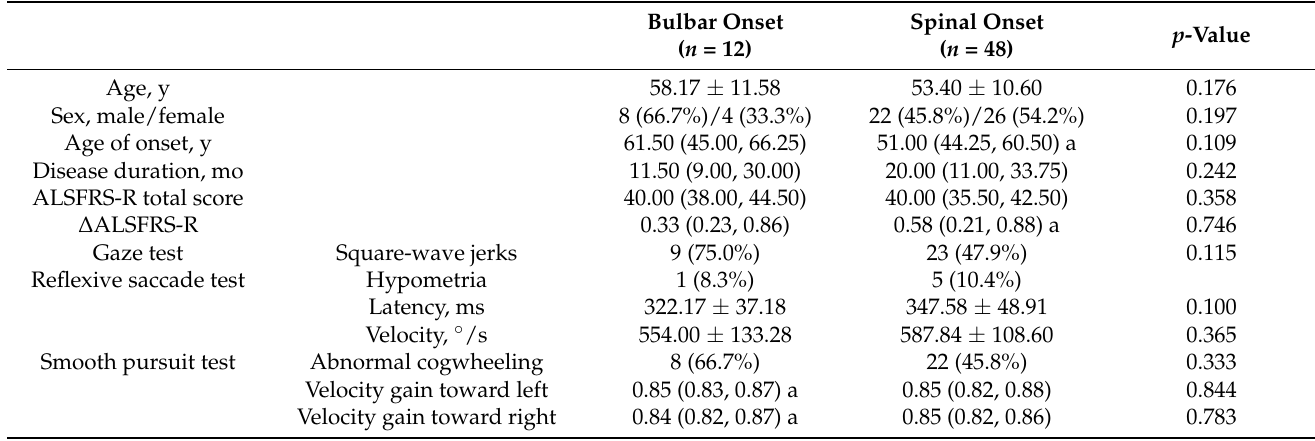
Table 6. Clinical data and oculomotor performance of bulbar-onset and spinal-onset ALS patients. Bulbar